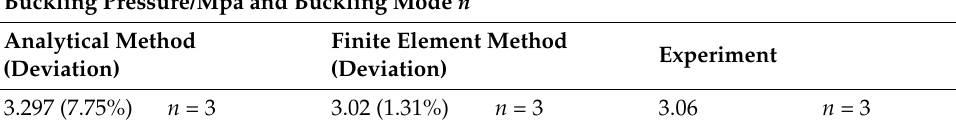
Table 6. Analytical, FEM and experimental results.